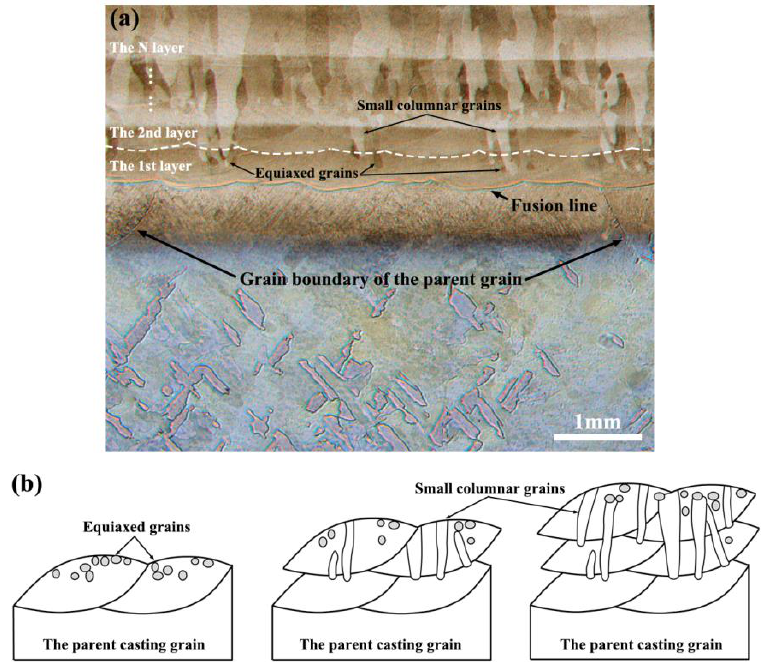
Figure 7. ( a ) Grains formed in the bonding zone of the hybrid sample, ( b ) schematic diagram illustrating the grain formation mechanism in the bottom of the LAM